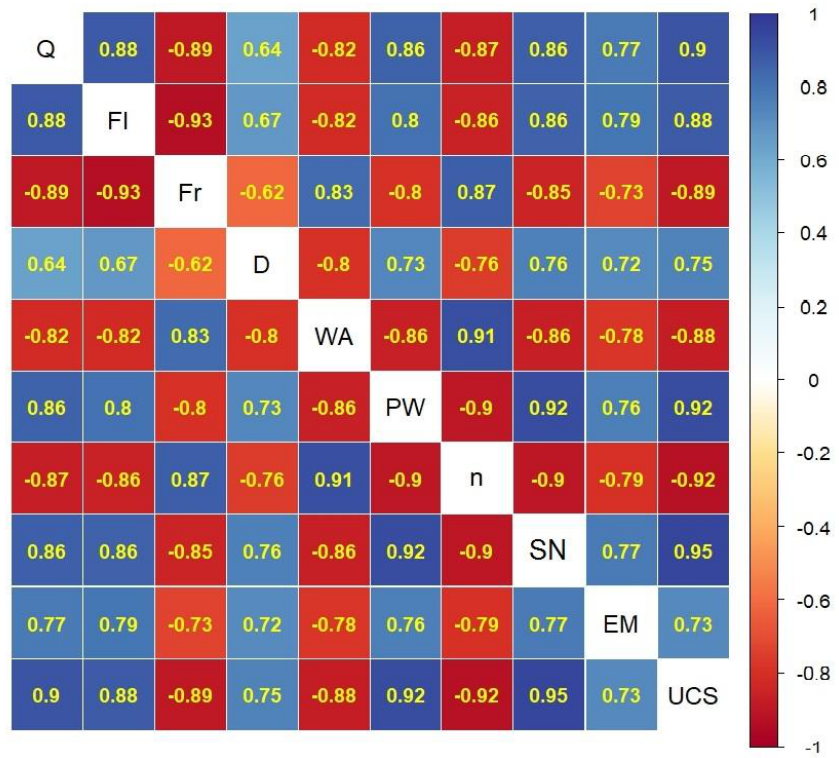
Figure 2. Correlation heatmaps of the measured variables. Table 3. Simple regression results. Regression